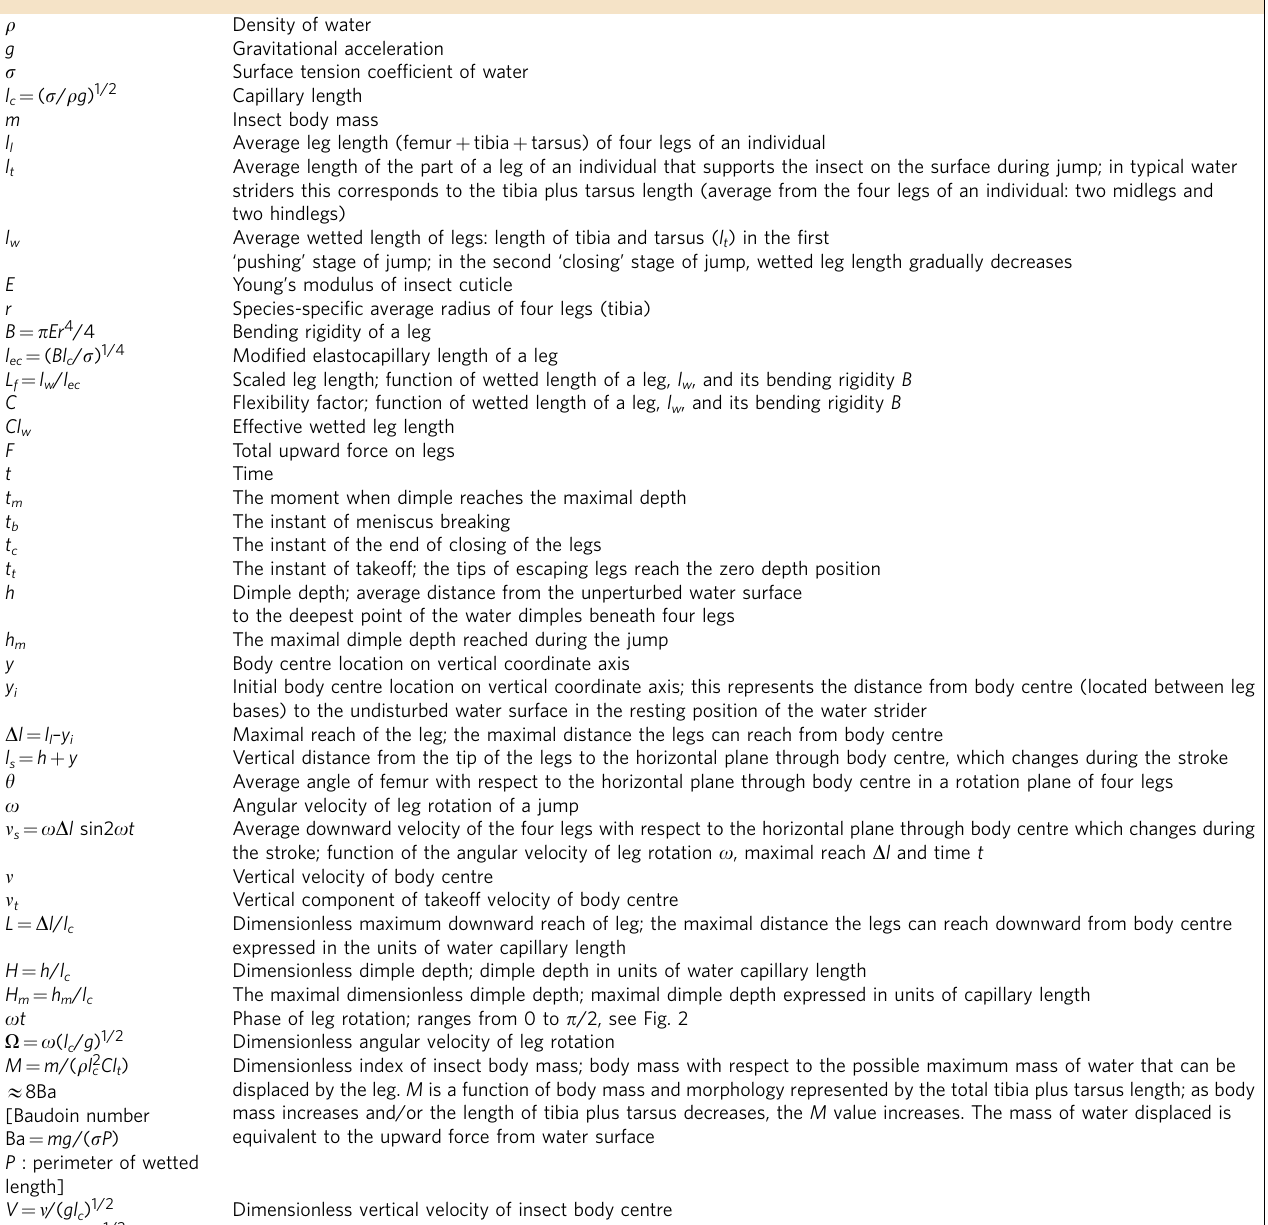
Table 1 | Explanations of the symbols in the model.